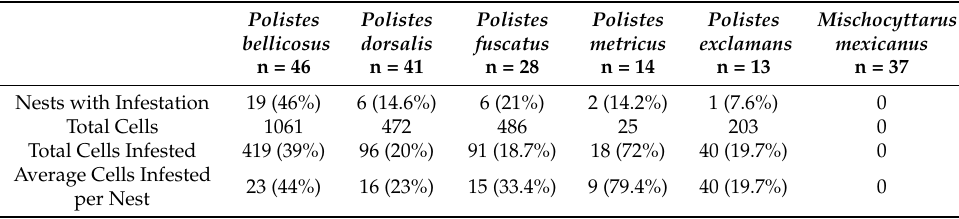
Table 1. Average number of cells infested per species by C. iphitalis in field colonies of Polistine wasps. Based on nests containing brood in the pupal